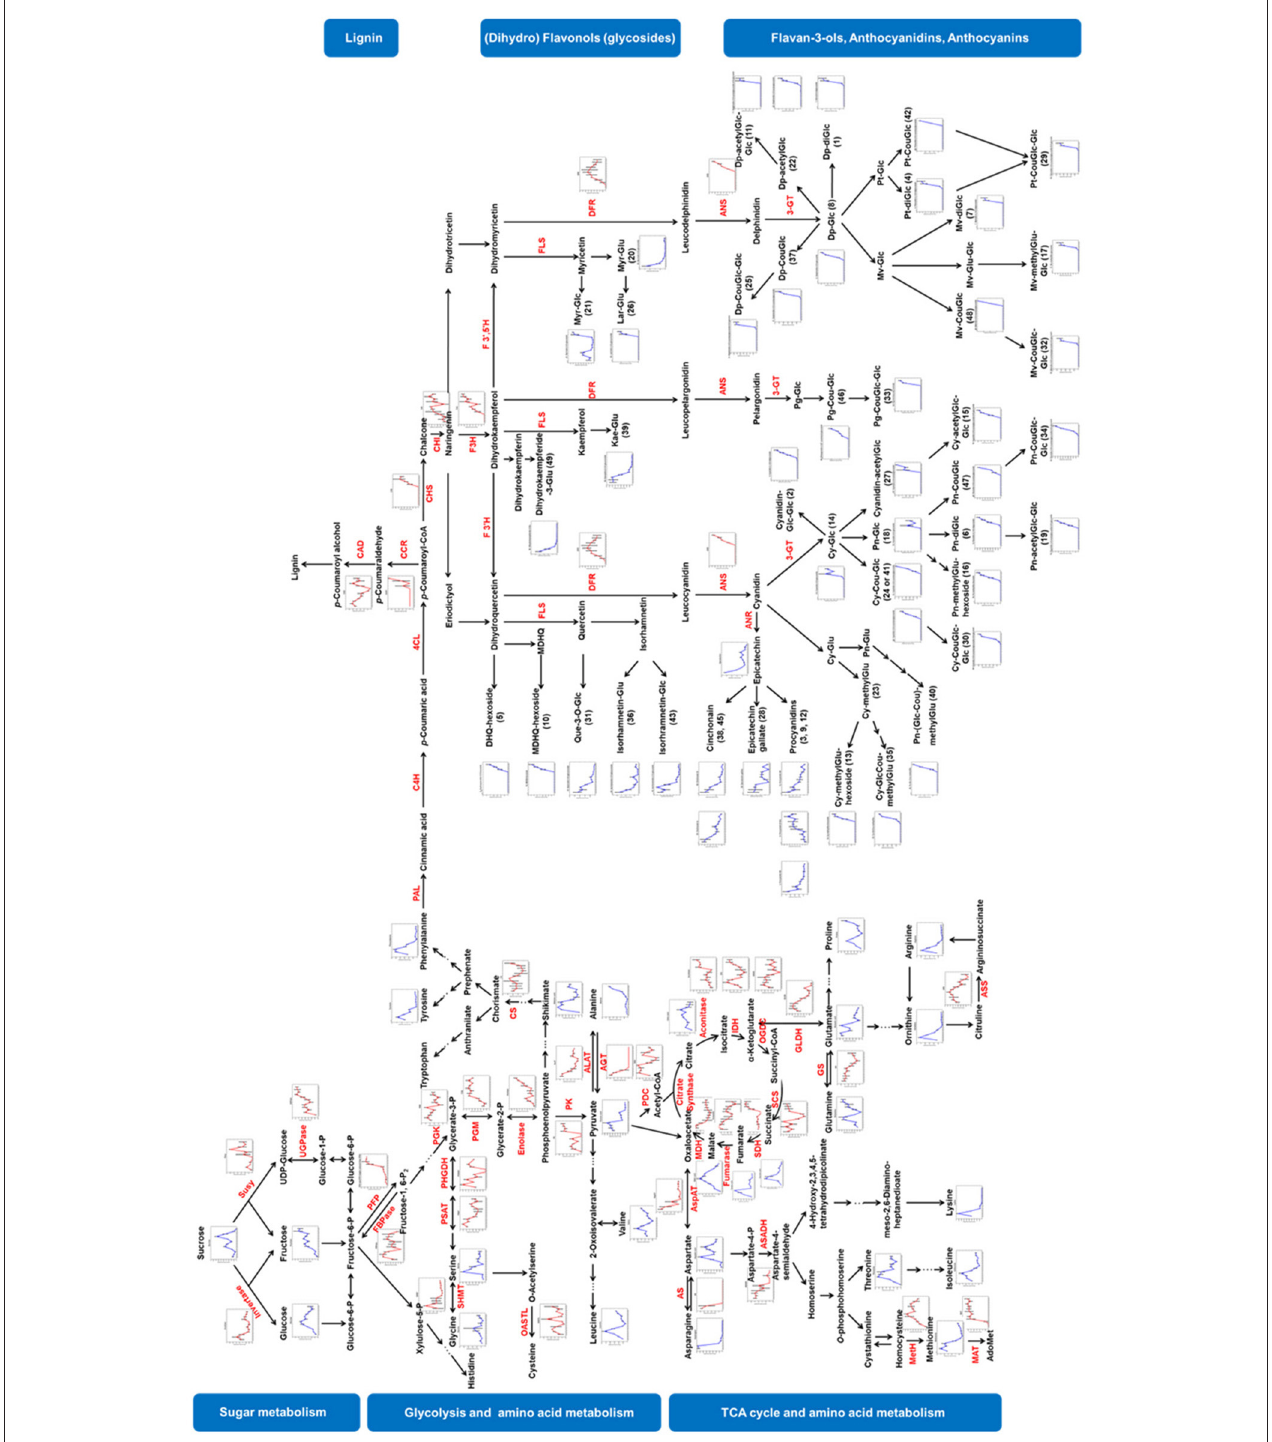
FIGURE 5 | Visualization of metabolite and protein dynamics on their biosynthetic pathways. Metabolites are written in black letters with blue line charts indicating their changing patterns whereas proteins are written in red letters with red line charts. Relative abundance of metabolites and proteins were averaged over three biological replicates. Bars represent standard errors. Susy, sucrose synthase; UGPase, UDP-glucose pyrophosphorylase; PFP, pyrophosphate-fructose 6-phosphate 1-phosphotransferase; FBPase, fructose 1, 6-bisphosphatase; PGK, phosphoglycerate kinase; PGM, phosphoglycerate mutase; PK, pyruvate kinase; PDC,